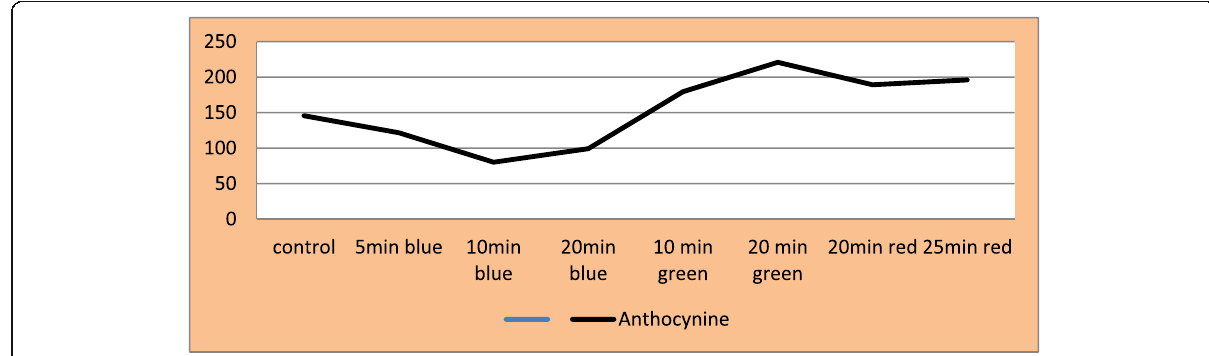
Fig. 3 Effect of laser radiation on anthocynine pigments content of Eustoma grandiflorum adapted plant (mg/100 g F.W)